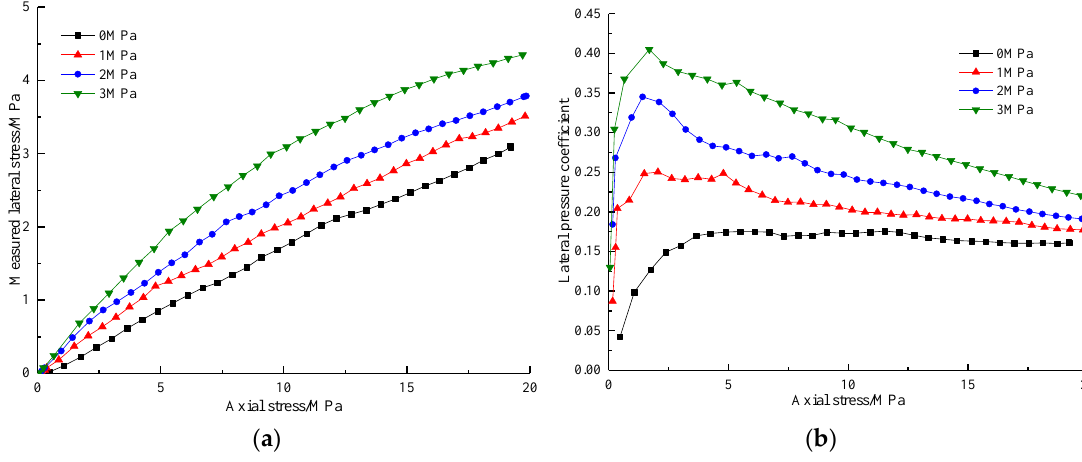
Figure 10. Changes in lateral stress and lateral pressure coefficient of samples under axial load. ( a ) Lateral stress; ( b ) Lateral pressure coefficient.